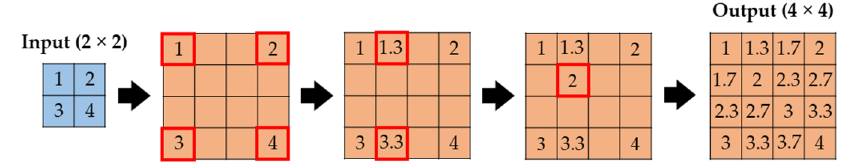
Figure 13. Up-sampling by bilinear interpolation.